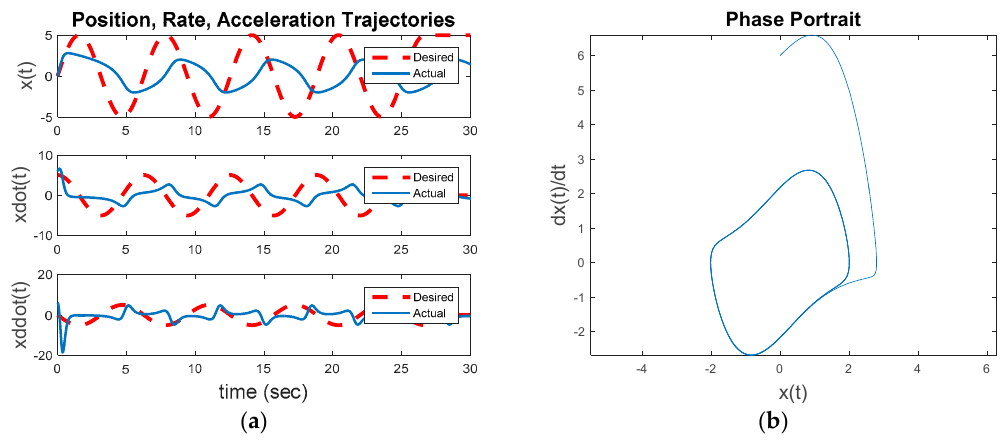
Figure 4. Commanding a desired trajectory as a circle of radius five with no control activated (neither feedback nor feedforward): ( a ) displays trajectory comparison; and ( b ) trajectory.